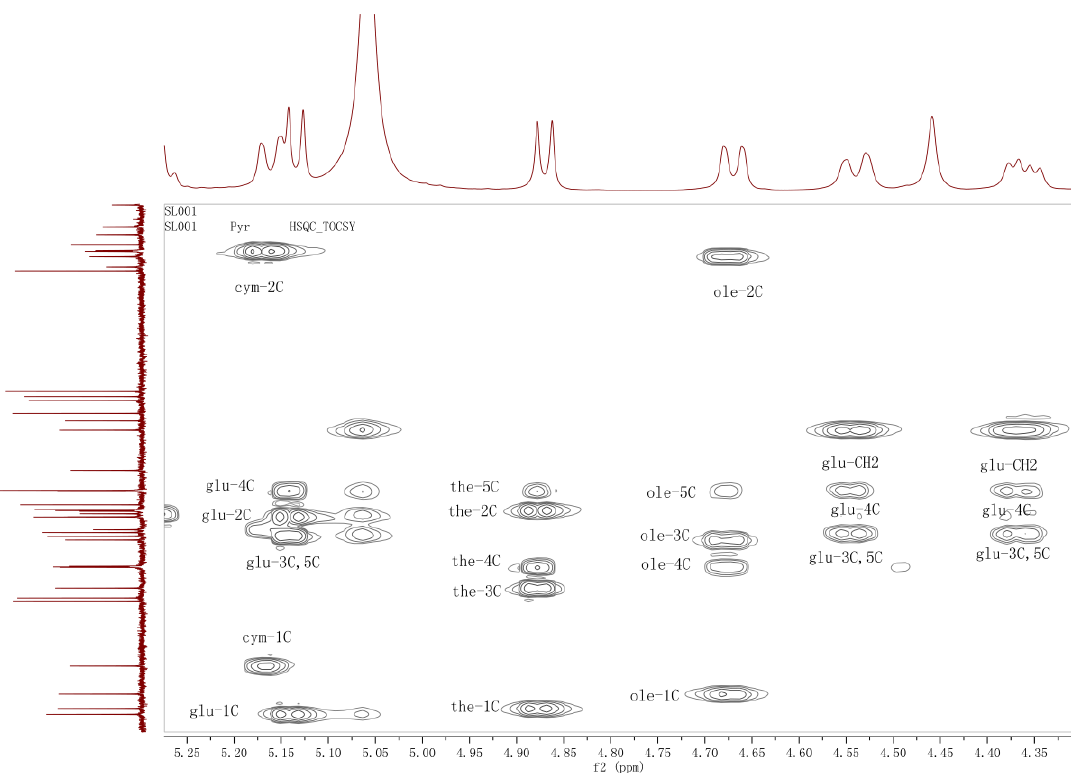
Figure 2. The HMQC-TOCSY spectrum of the glycosyl part of 5 .